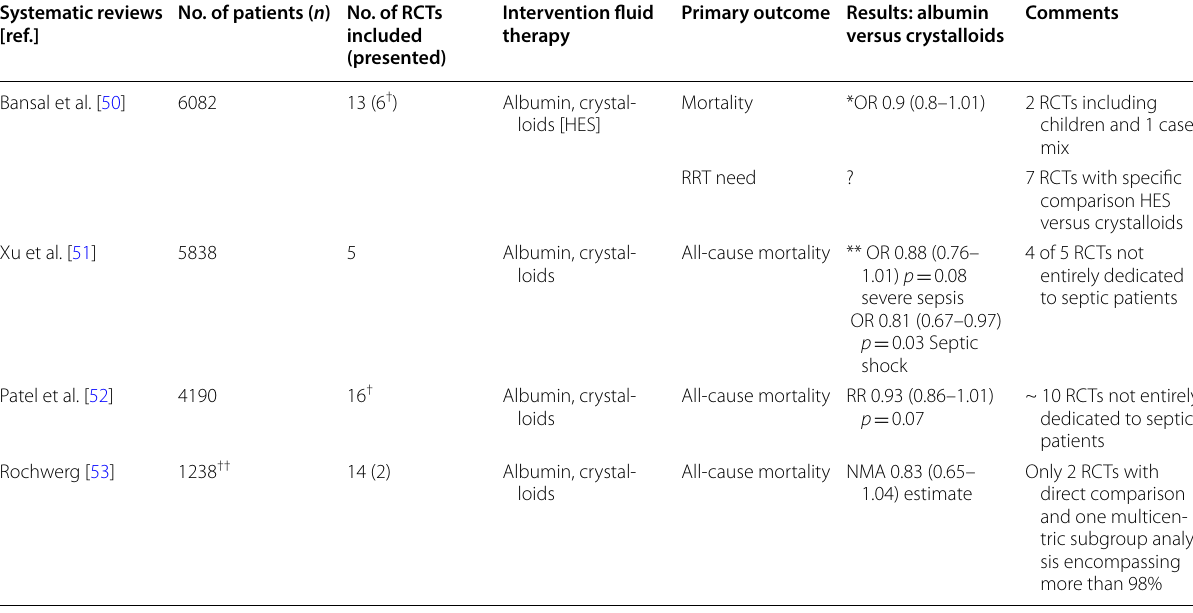
RCT S randomized control trials, OR odds ratio, RR relative risk, HES hydroxy ethyl starches, NMA nodal meta-analysis *28- and 30-day